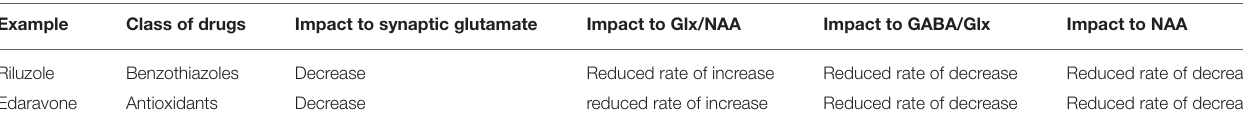
TABLE 6 | Predictions on MRS detected changes over time in ALS patients taking Riluzole and Edaravone, both of which target enhancing astrocytic glutamate uptake and therefore lowering synaptic and extracellular glutamate levels, relative to ALS patients not taking these drugs. Example Class of drugs Impact to synaptic glutamate Impact to Glx/NAA Impact to GABA/Glx Impact to NAA Decrease Reduced rate of increase Reduced rate of decrease Reduced rate of decrease Antioxidants Decrease reduced rate of increase Reduced rate of decrease Reduced rate of